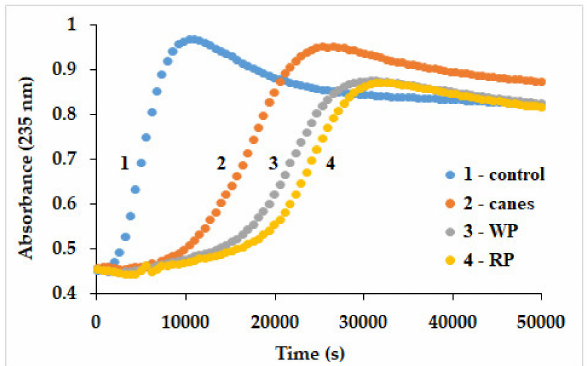
Figure 5. Time course for the oxidation of liposomes catalyzed by cytochrome c in the presence of the pomace (white and red pomace—WP, RP) and canes (C) extracts. Conditions: cytochrome c —2 µ M, liposomes—0.5 g / mL, extracts—16.7 µ g / mL, phosphate bu ff er—10 mM, pH